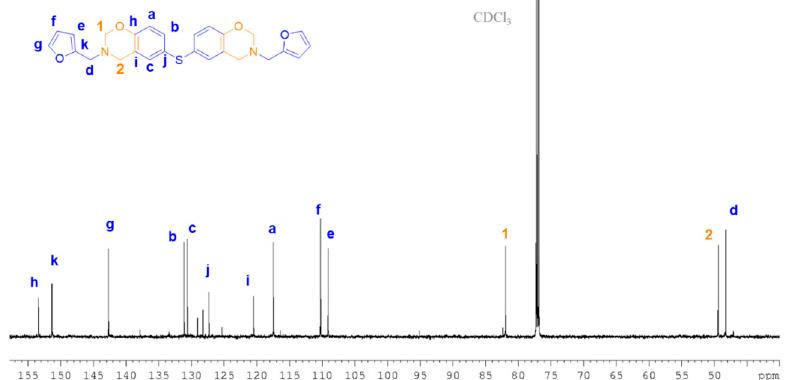
Figure A13. 13 C NMR spectrum in CDCl 3 of 4DTP-fa.